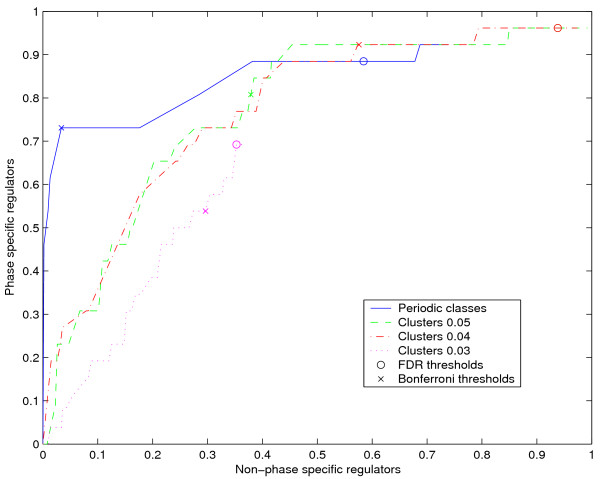
Specificity towards cell cycle regulators. Fraction of cell cycle regulators included in rules versus fraction of non-cell cycle regulators included in rules for different significance threshold. "Periodicity" refers to the method based on periodic classes presented here, "Cluster d" refers to applying the method of Hvidsten et al. [7] using the Euclidean distances d for including a gene in a cluster. Bonferroni (BF) and FDR corrected thresholds (at the 0.05 level) are shown for each method (Note that the FDR thresholds for "Clusters 0.04" and "Clusters 0.05" are located at the same point).